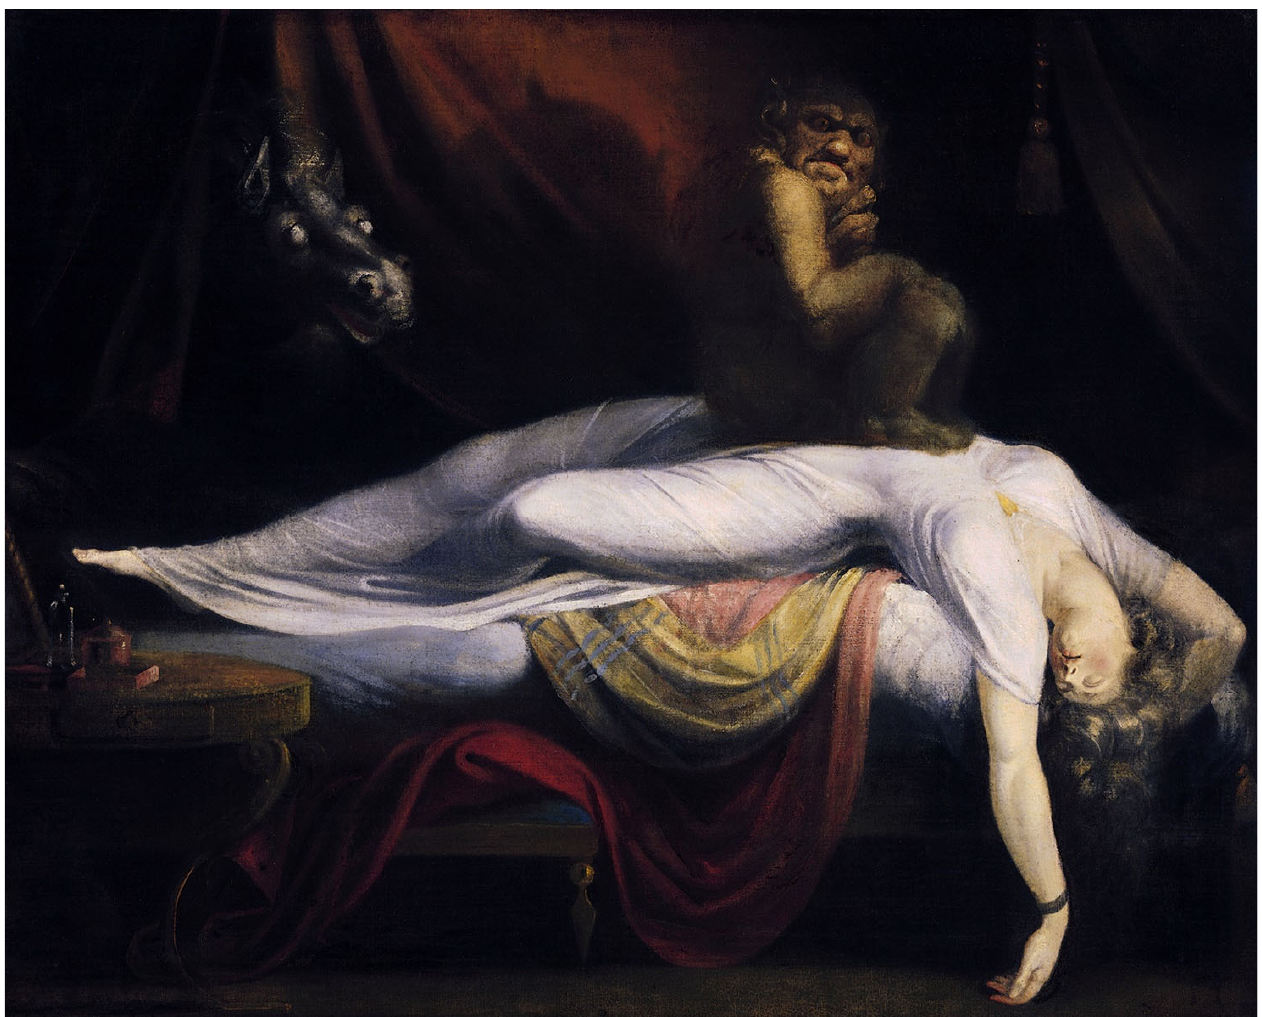
Figure 11. Johann Heinrich Füssli (1741–1825) painted this picture in 1781. It expresses the belief at the epoque that the nightmare word is based on the German word Nacht. The root word of mare is the Teutonic word mar to designate a devil and becomes mare. Mare is also the English word for a female horse which is why a female horse is depicted leering in the back left of the painting. (Permission to reproduce granted by the Detroit Institute of Art).